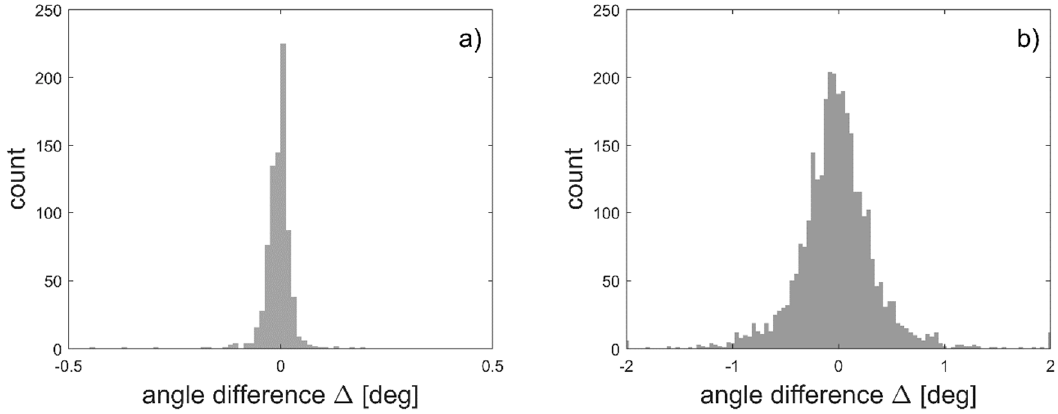
Figure 4. Histograms of angles ∆ calculated from data obtained in Experiment 1 with: ( a ) laser tracker; ( b ) motion capture system.